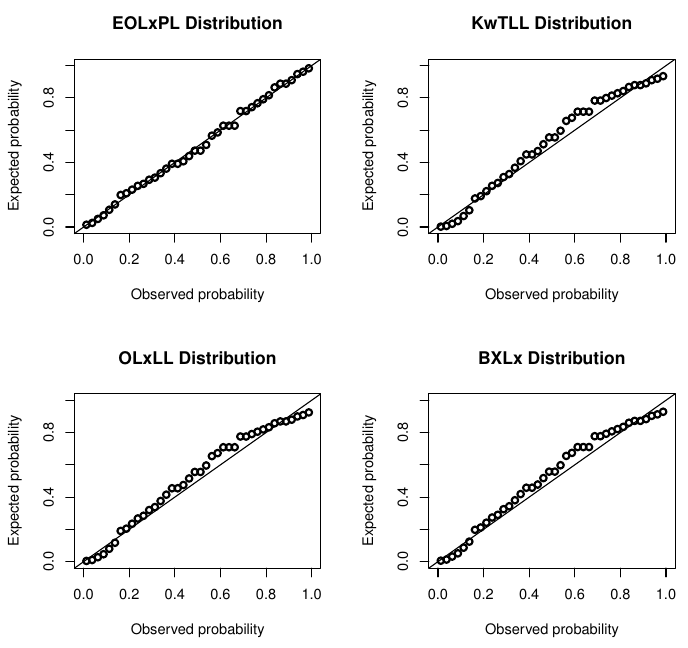
Figure 7 – P-P plots of EOLxPL, KwTLL, OLxLL and OP